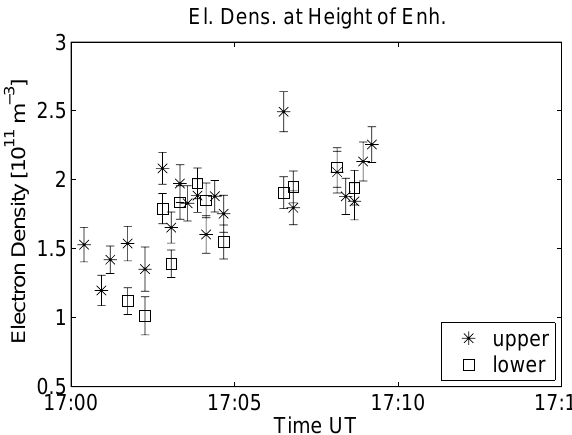
Fig. 4. The electron densities at the altitude of the observed en- hancements in backscattered radar power are shown, where aster- isks correspond to the upper layer and squares to the lower layer. The mean electron density is 1.76 × 10 11 m − 3 . Integration of 4s was used.